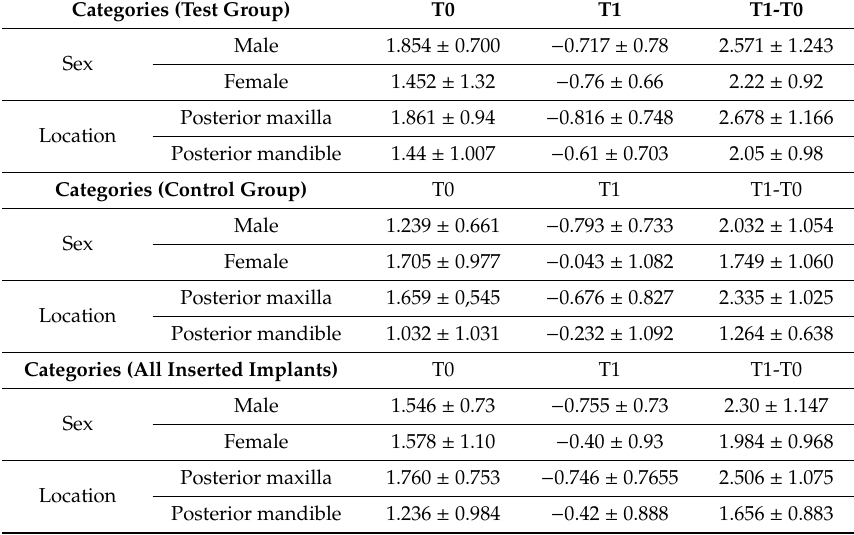
Table 2. Marginal Bone Loss related to sex and location (mean ± SD, mm) of the implants, in the test and control groups and the cumulative value of all the implants inserted in the